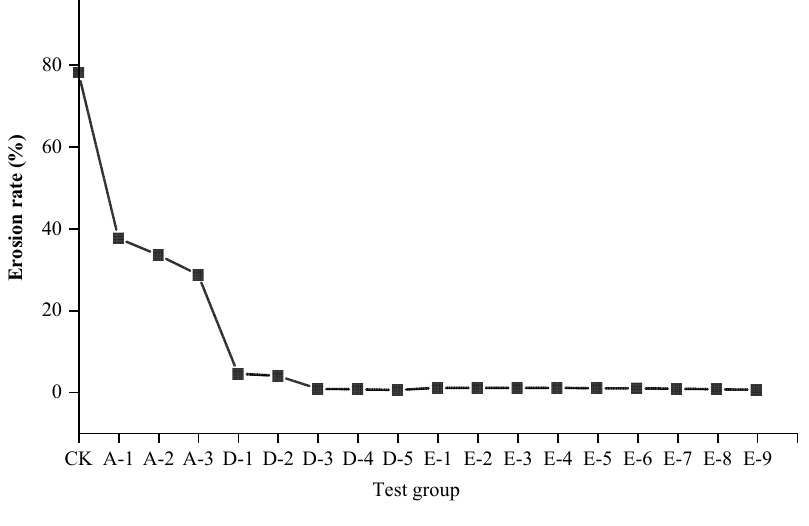
Figure 7. Results of the erosion resistance